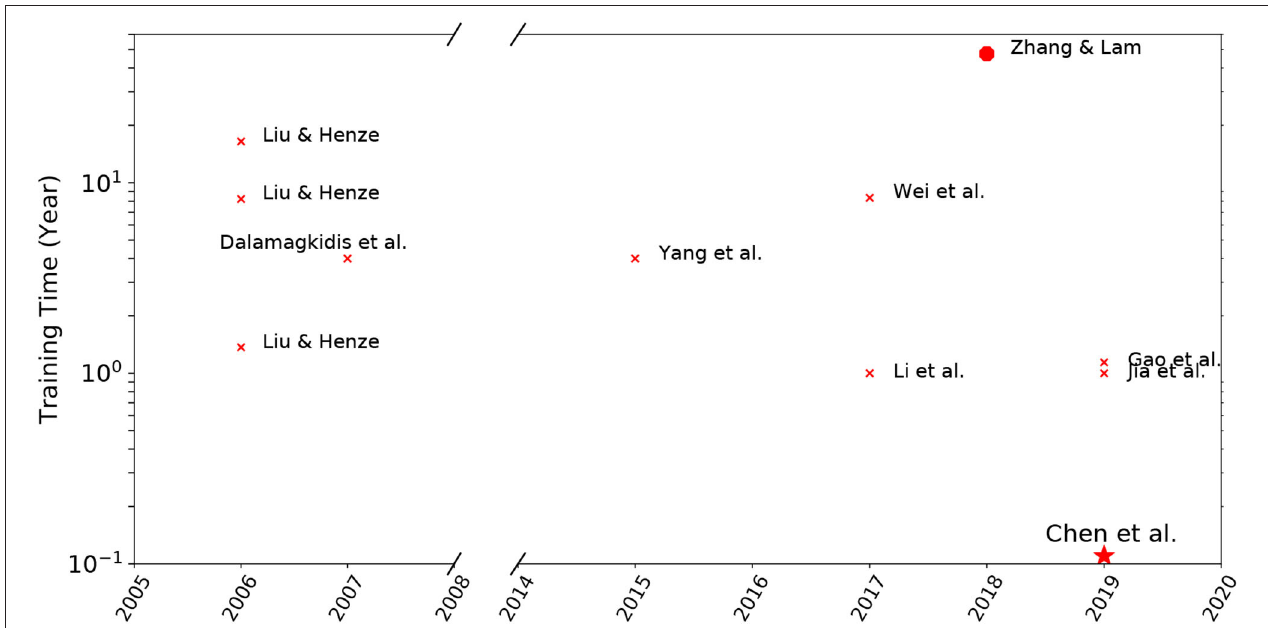
FIGURE 2 | Summary of training time reported in the literature; By incorporating domain knowledge and expert demonstration, our proposed Gnu-RL agent drastically reduced training time compared to existing